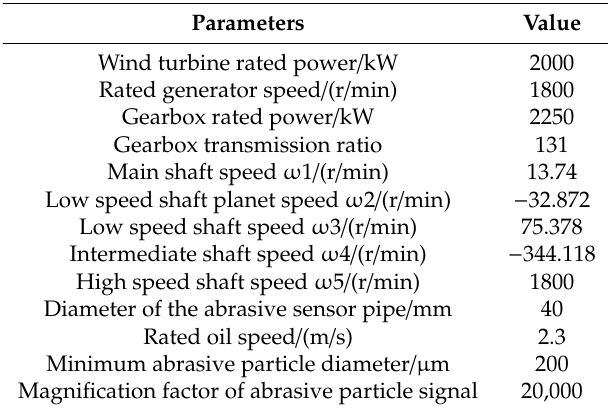
Table 2. Parameters of experimented wind